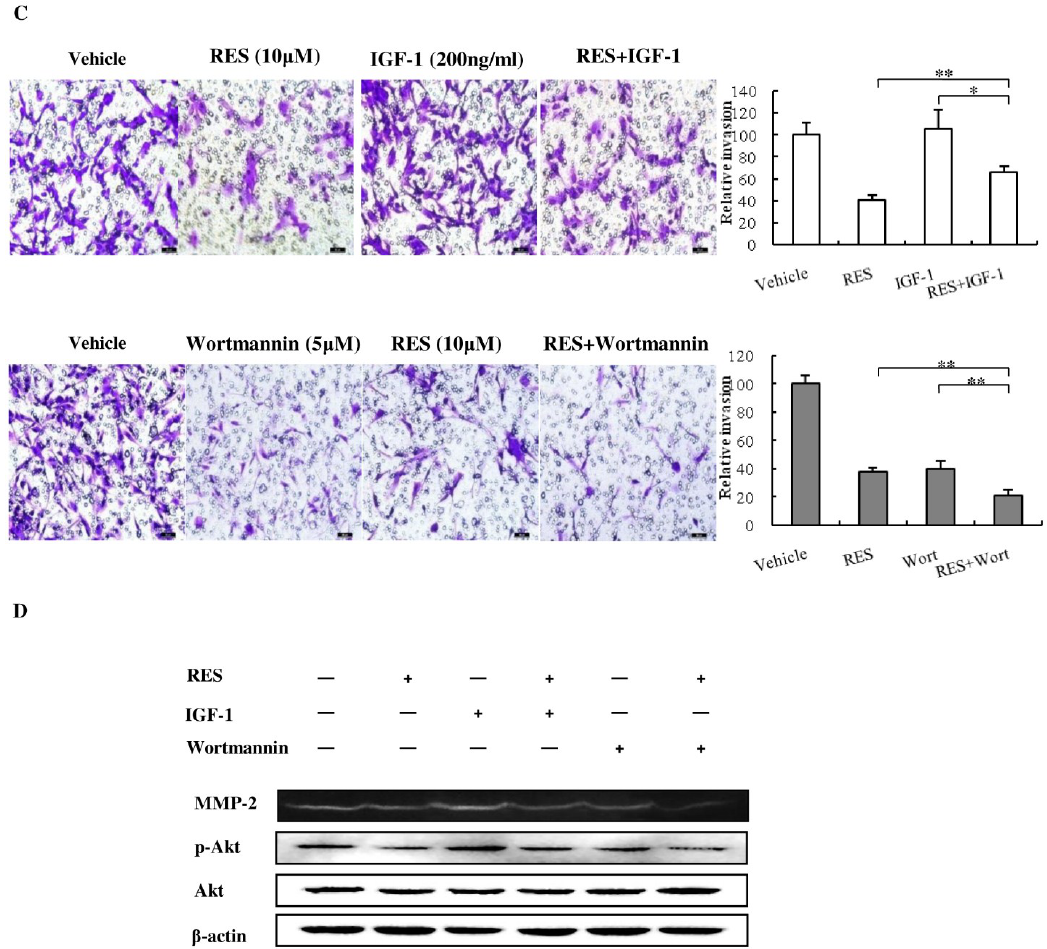
Figure 6. PI3K/AKT signaling pathway is involved in the inhibitory effect of RES on NF-κB activation. ( A ) GICs (412) were treated with DMSO (vehicle) and 5 μM, 10 μM, and 20 μM RES for 48 h. Total expression and phosphorylation of Akt and mTOR were analyzed by western blotting using anti-Akt, anti-p-Akt, anti-mTOR, anti-p-mTOR, antibodies. β-actin was used as a loading control; ( B ) Total expression and phosphorylation of JNK, ERK, and p38 were analyzed by western blotting using anti-JNK, anti-p-JNK, anti-ERK, anti-p-ERK, anti-p38 anti-p-p38 antibodies. β-actin was used as a loading control; ( C ) GICs (412) were pre-treated with IGF-1 (200 ng·mL −1 ) or wortmannin (5 μM) for 30 min and then incubated in the presence or absence of RES (10 μM). GICs were then subjected to cell invasion assay. Then, randomly chosen fields were photographed (200×), and the number of cells that migrated to the lower surface was calculated as a percentage of invasion. Data are shown as the mean ± SD of three independent experiments by Student’s t -test. * p < 0.05, ** p < 0.01; ( D ) GICs were pre-treated with IGF-1 (200 ng·mL −1 ) or wormannin (5 μM) for 30 min and incubated in the presence or absence of RES (10 μM) for 48 h, and then, the cell lysates were subjected to western blotting with anti-p-Akt and anti-Akt antibodies. β-actin was used as a loading control. The CM were subjected to gelatin zymography assay to determine the activity of